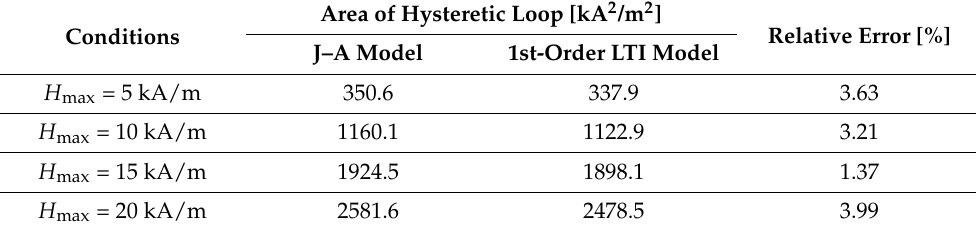
Table 1. Calculated areas covered by the hysteresis curves from J–A model and 1st-order LTI system